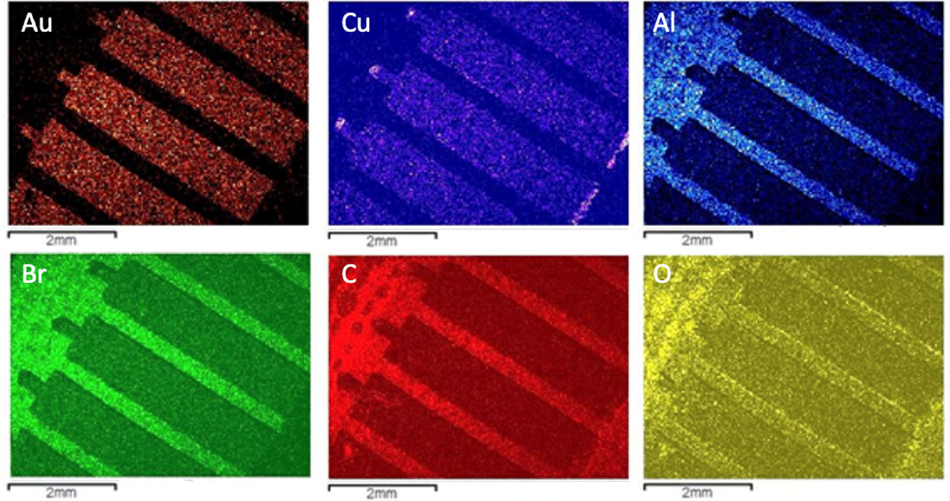
Figure 6. Chemical mapping of the most relevant elements detected in the microanalysis of the dark and bright areas of the Type 2 WEEE sample.